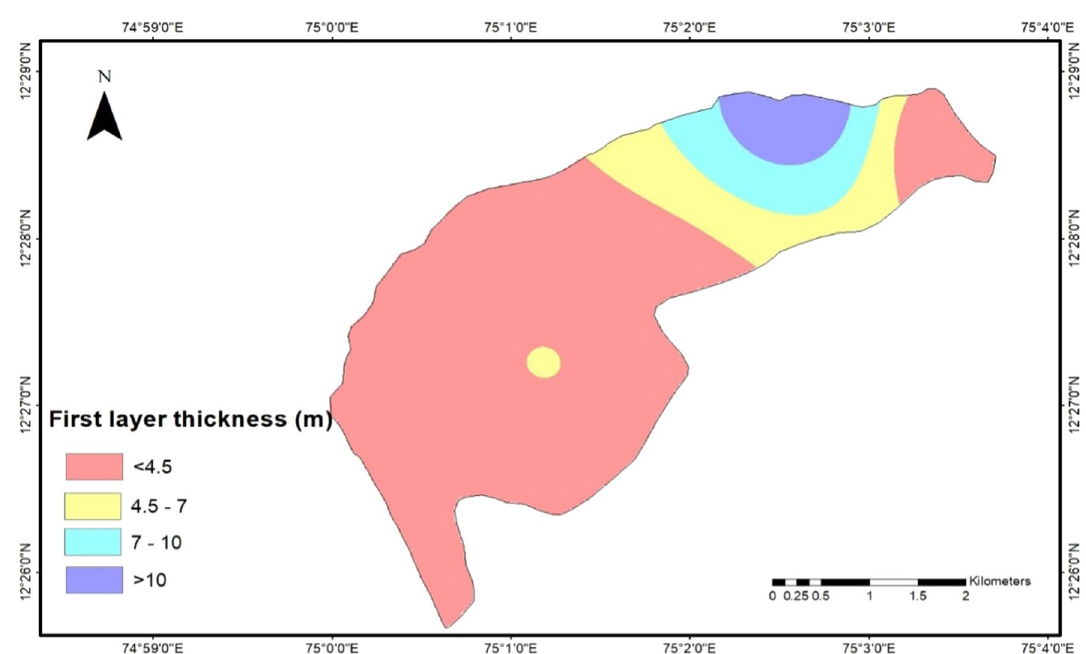
Fig. 5 Spatial variation thickness map of first layer